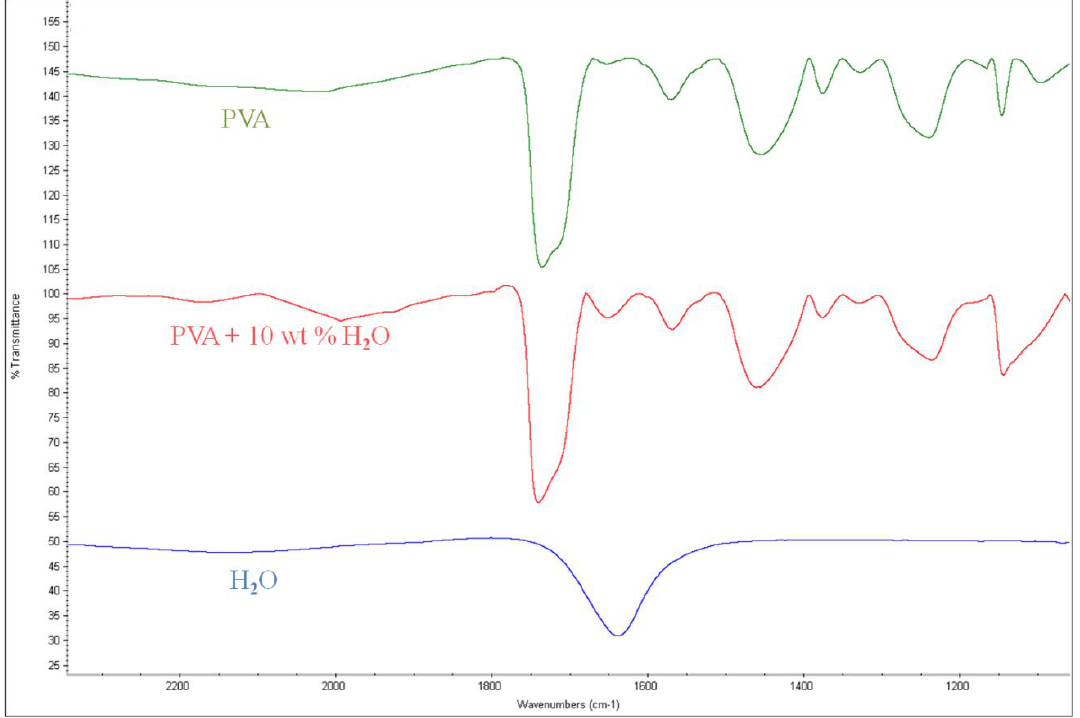
Figure 12. FTIR spectra for the comparison of PVA with and without